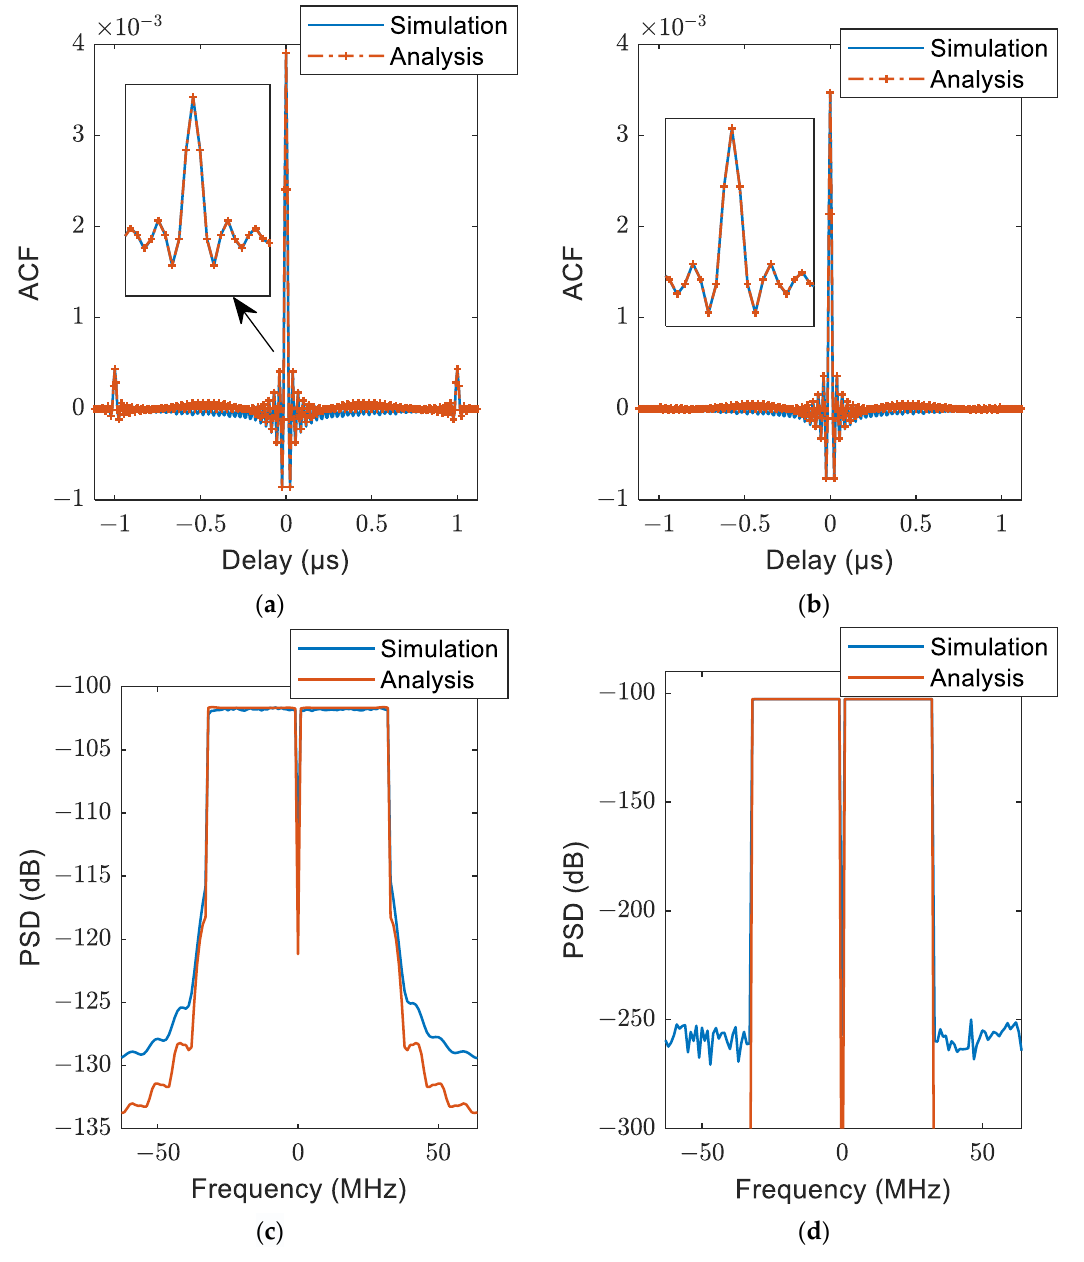
Figure 2. Comparison of the ACF and PSD simulation results and the theoretical results of the OFDM navigation signals. ( a ) The ACF of the OFDM navigation signal in cyclic prefix mode; ( b ) The ACF of the OFDM navigation signal in zero-padding mode; ( c ) The PSD of the OFDM navigation signal in cyclic prefix mode; ( d ) The PSD of the OFDM navigation signal in zero-padding